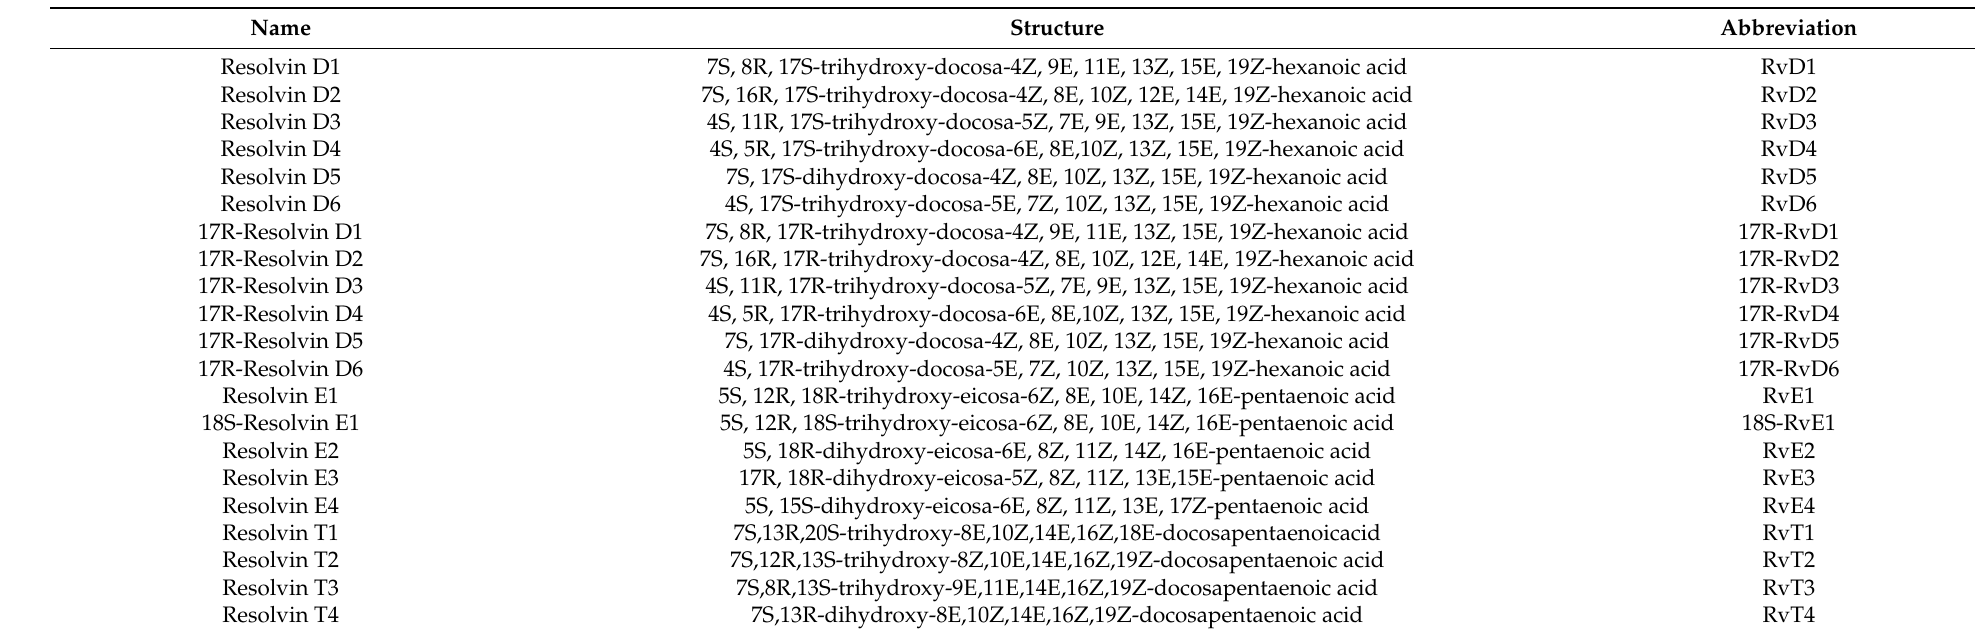
Table 1. The complete stereochemical structure and related abbreviation of